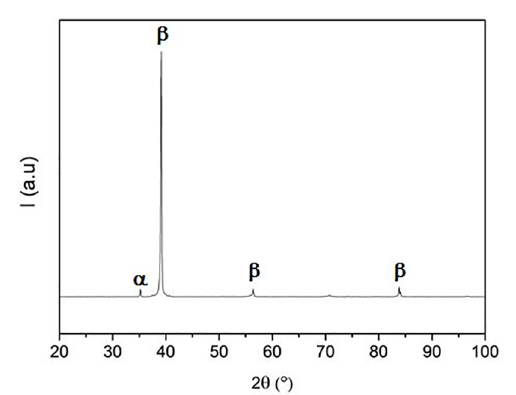
Figure 1. XRD pattern of Ti-12Mo-8Nb alloy hot swaged, annealed at 950°C/1h and water quenched.